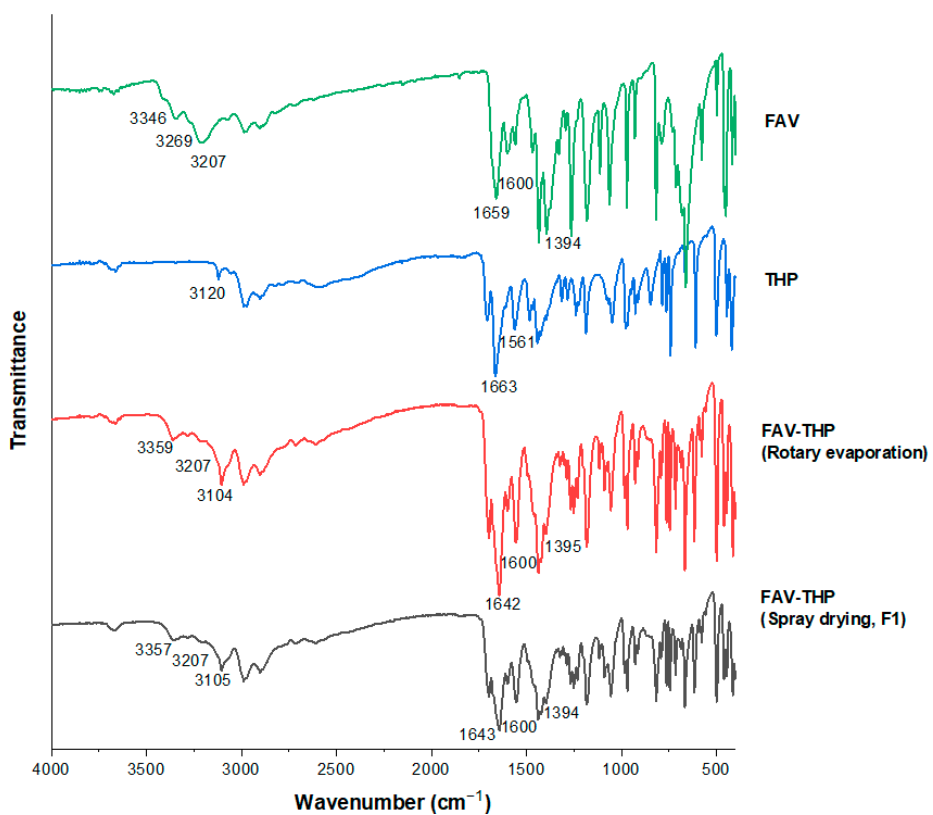
Figure 4. FTIR spectra of the FAV-THP cocrystal systems.